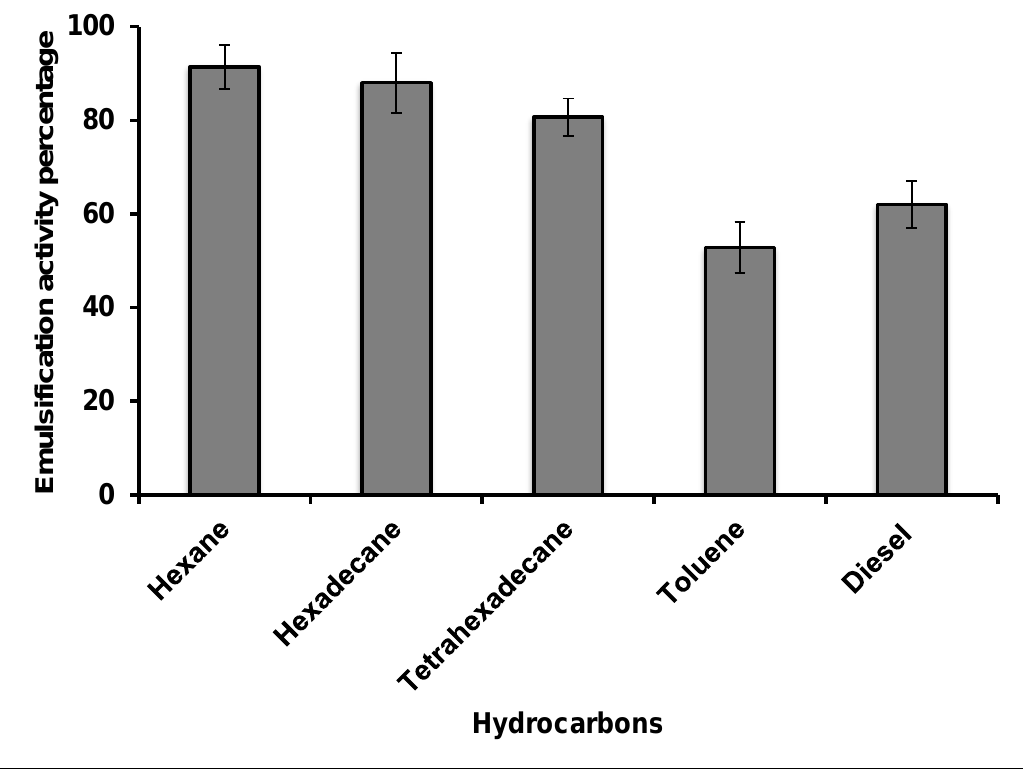
Figure 2. Emulsification index (E 24 ) for cell-free broth from bacterial cultures after incubation for 72 h. Error bars represent mean ± standard deviation, 𝑛 = 3.